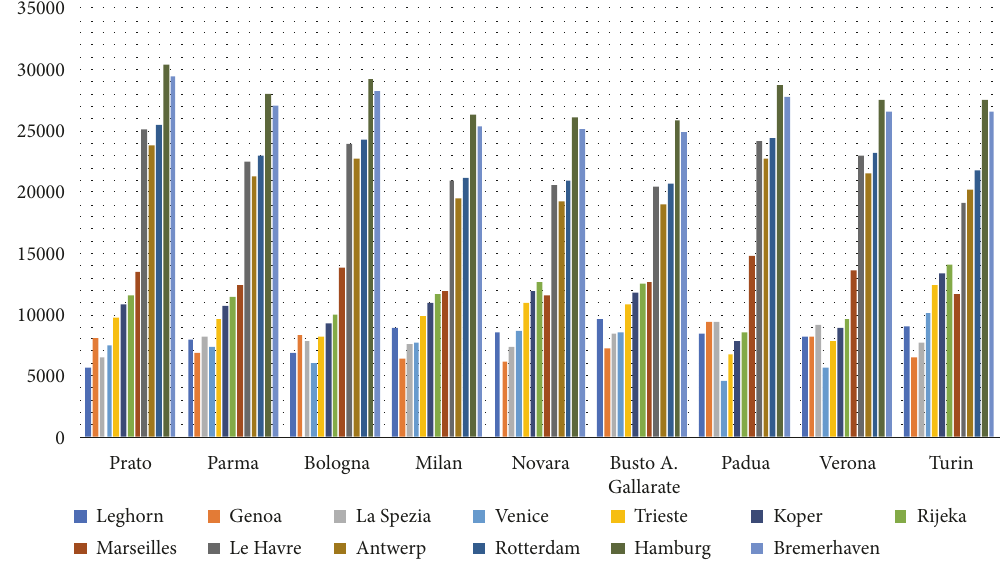
Figure 4: Monetary costs of a full train (€) from the ports considered in the analysis, towards Italian destinations. Optimisation by monetary